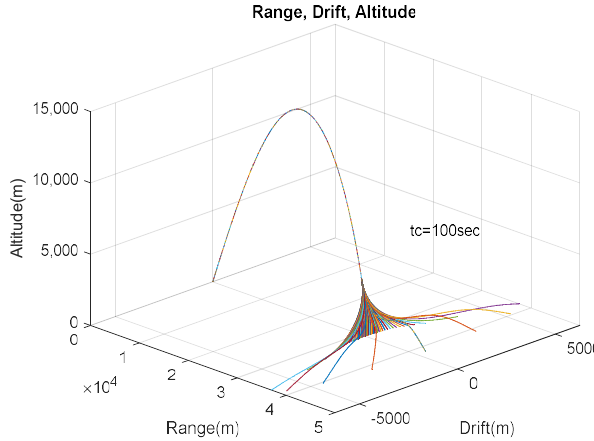
Figure 10. Control Activated at 100 s.